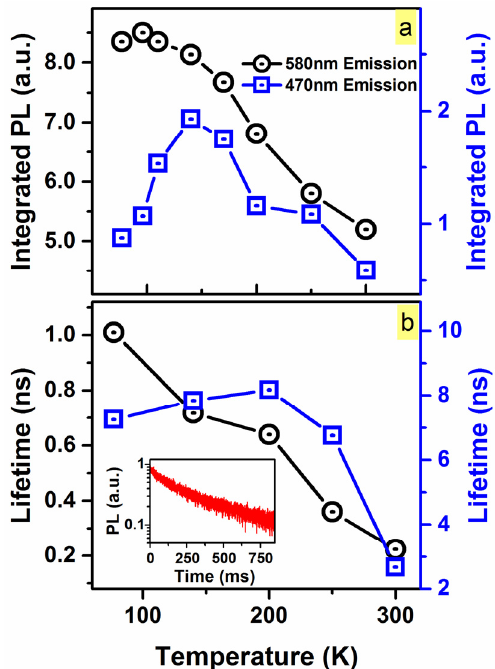
Figure 5. Temperature dependence behavior of ( a ) the I PL and ( b ) luminescence lifetime for the ~470 and ~580 nm components deconvoluted from the spectra of the N 2 900 °C passivated SiC 0.3 O 1.6 sample. A monotonic increase in the I PL of the 580 nm component was observed as temperature was decreased, which was also reflected in the luminescence lifetime. The I PL of the 470 nm component increased until 140 K, and then decreased as temperature was lowered to 77 K. Below room temperature, the apparent luminescence lifetime of the 470 nm component plateaued around 8 ns; however, under the acquisition parameters used during the measurement, the ~8 ns extracted is not the lifetime, but is the upper limit of the measurement, with the values exhibiting a standard deviation of ± 2.2 ns below 250 K. Inset: Time-resolved photoluminescence (TRPL) spectrum of the 470 nm component acquired at 140 K with a microsecond flashlamp (repetition rate of 1 Hz) .